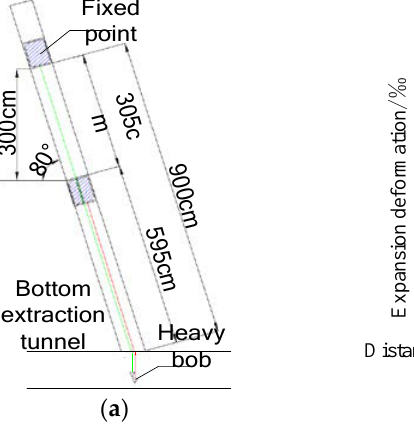
Figure 7. Ding protects Wu area: ( a ) NO. 1 measuring point gas pressure test data; ( b ) NO. 2 meas-